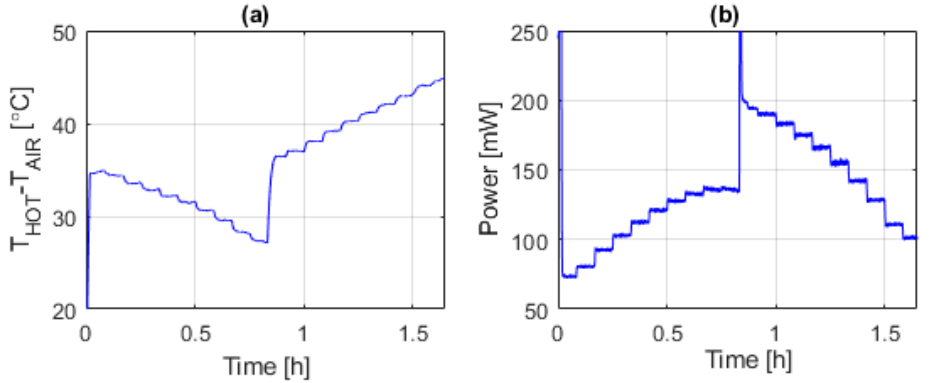
Figure 6. Time evolution, during the first experiment, of: ( a ) The pressure in the wind tunnel; ( b ) rotation speed of the fan in the wind tunnel; ( c ) temperature of the air; ( d ) temperature in the sphere sectors. The wind velocities tested were: 1.5, 2, 3.6, 5.6, 7, 9, 10, 12, 14, 16 m/s.